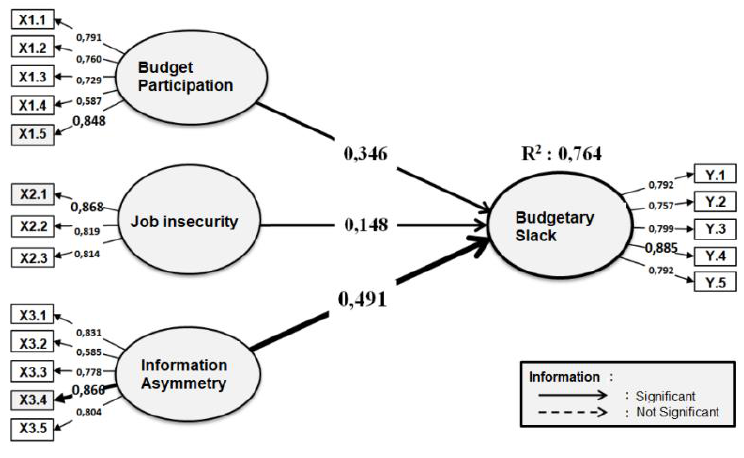
Figure 1: Path Diagram of Measurement Model and Structural